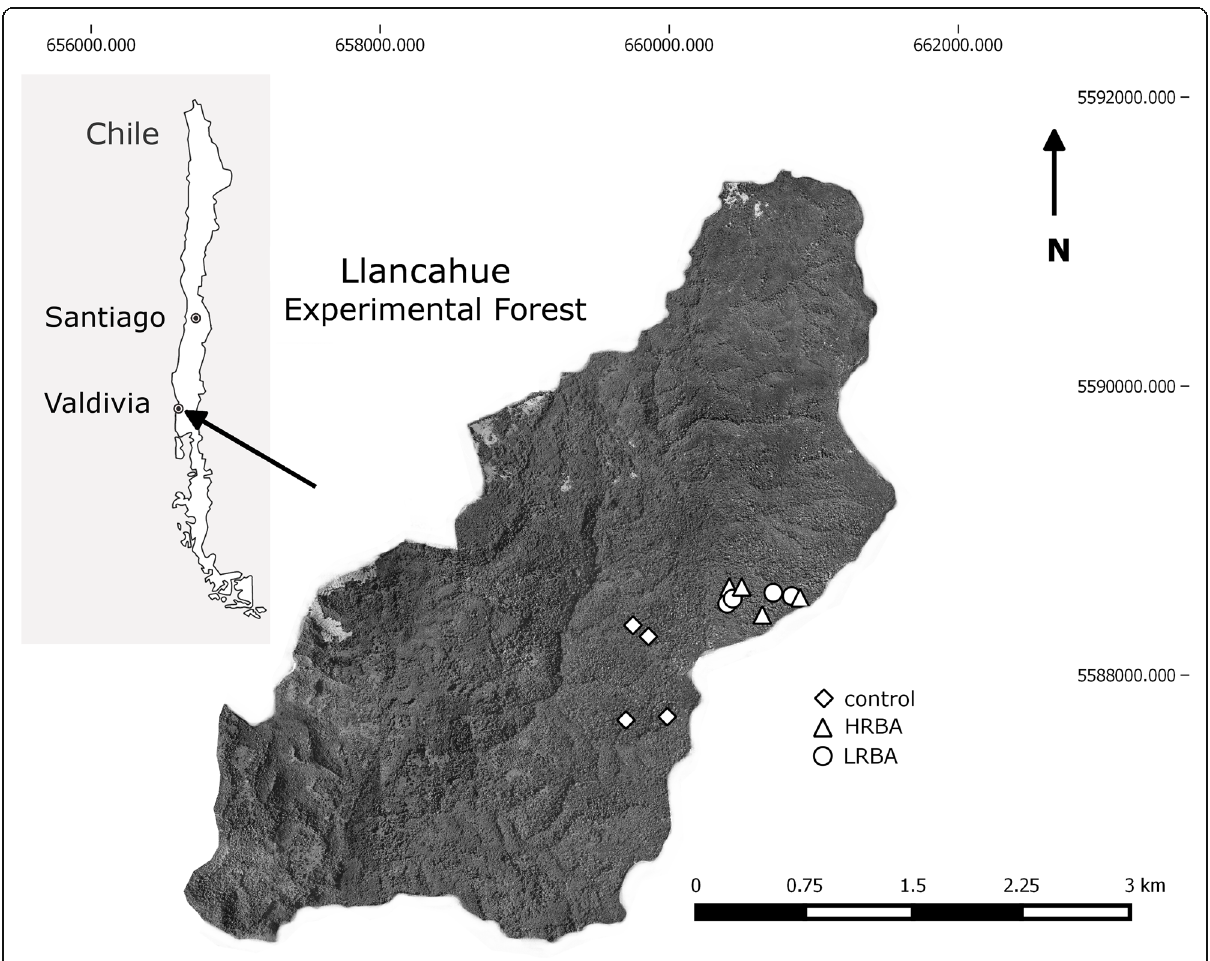
Fig. 1 Study area showing the location of old-growth control ( n = 4), high residual basal area (HRBA, n = 4) and low residual basal area (LRBA, n = 4)